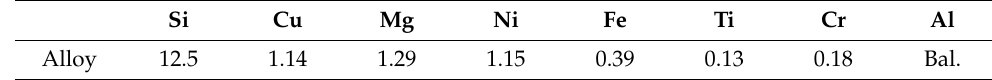
Figure 1. Melting process flow chart. Table 1. Chemical composition of the alloy (wt.%). Table 1. Chemical composition of the alloy (wt.%).